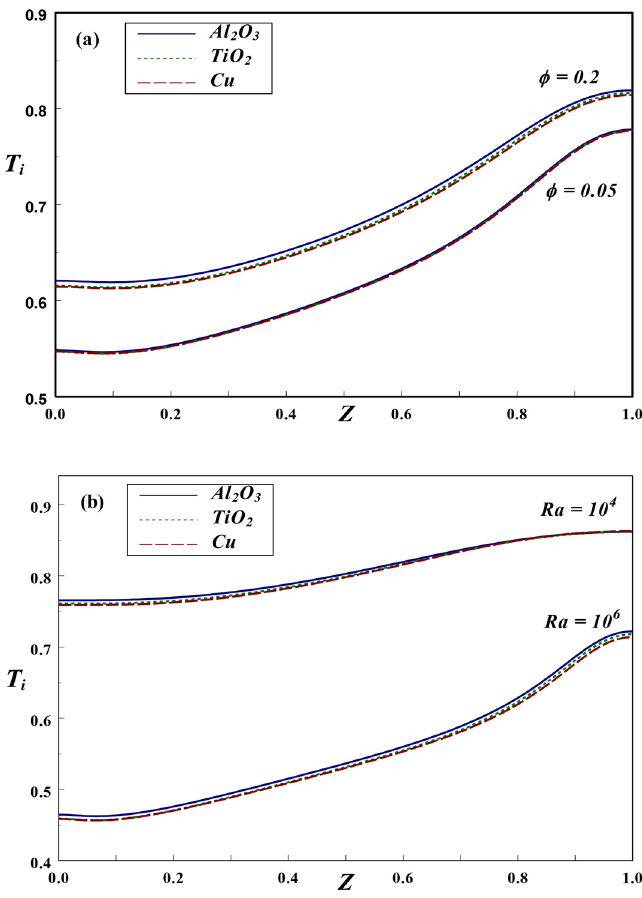
Figure 15. Axial variation of interface temperature with different ( a ) φ and ( b ) Ra